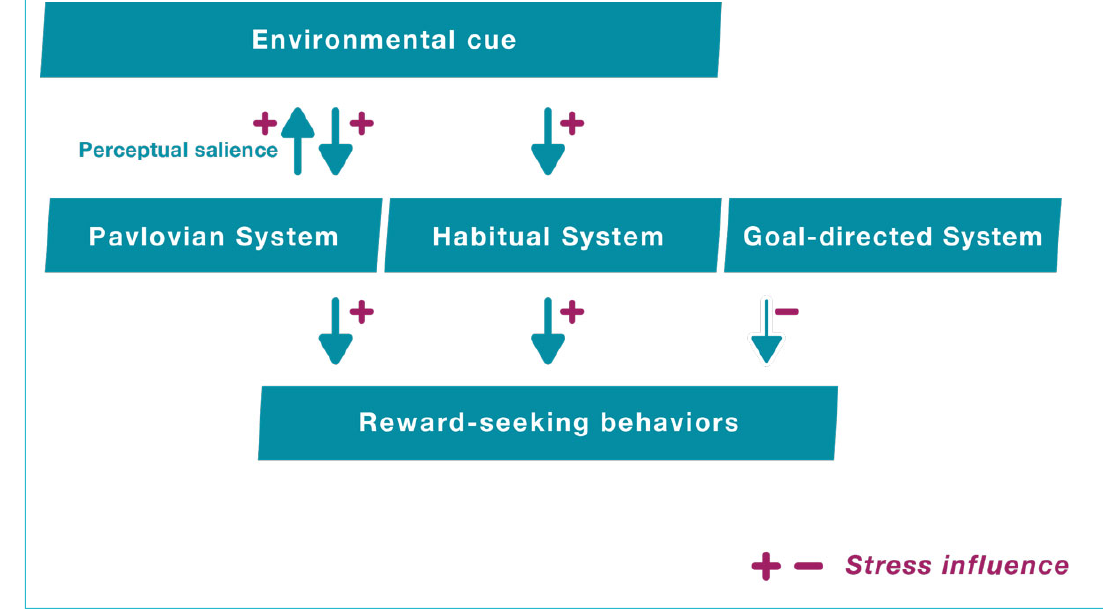
Figure 3: Illustration of the proposed influence of stress on reward-seeking behaviours. The plus and minus signs symbolise the influ- ence of stress. Stress increases the Pavlovian and the habitual controls (driven by environmental cues) over the goal-directed control (driven by the representation of an individual’s current goals). The increased Pavlovian control enhances the perceptual salience of reward-associated environmental cues and the perception of these cues triggers habits determining which action is executed. Pavlovian motivational bursts also determine how much effort is invested in this